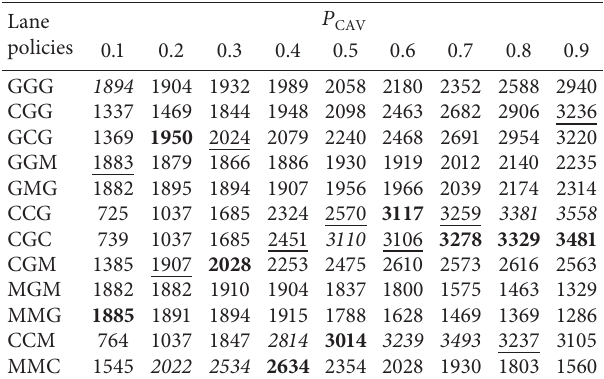
values (three-lane